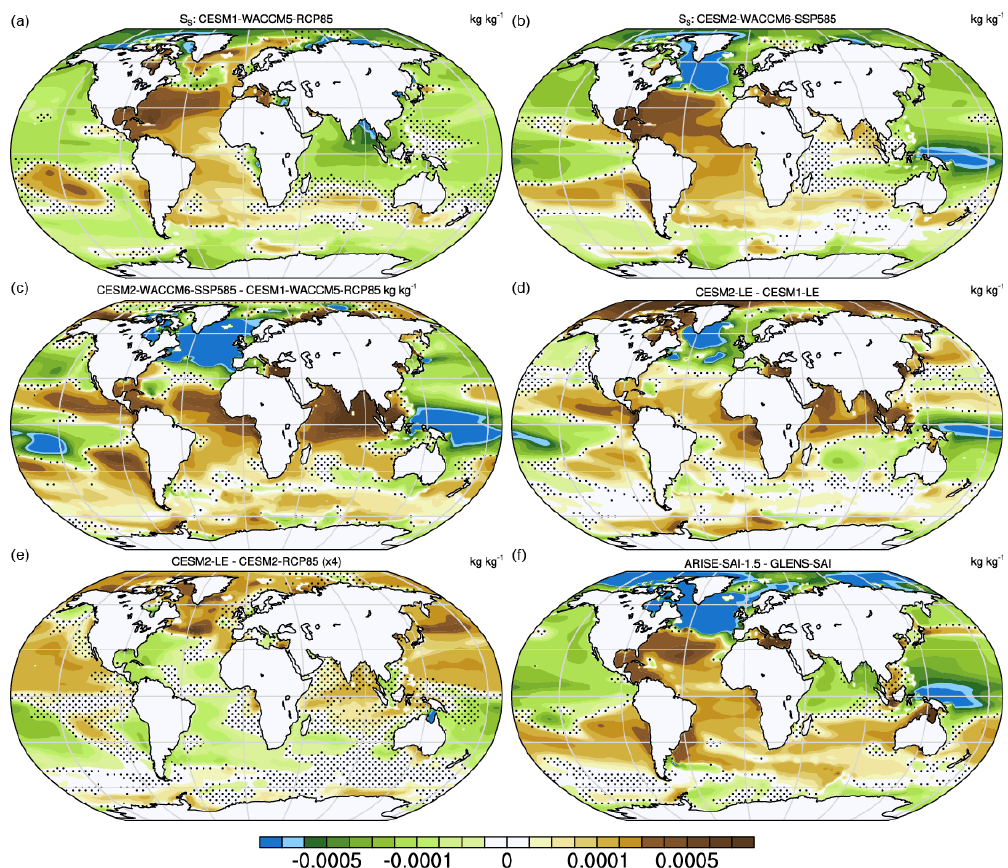
Figure A7. Response in surface salinity (S S ) estimated from the change between 2020–2039 and 2050–2069 for unmitigated (a) CESM1- WACCM5-RCP85 and (b) CESM2-WACCM6-SSP585 simulations, and their difference (c) . Also shown is the analogous difference for (d) CESM1-LE and CESM2-LE (d) and (e) CESM2-RCP85 and CESM2-LE. The difference between the geoengineered climate states in ARISE-SAI-1.5 and GLENS-SAI is shown in panel (f) . Units for all panels are kgkg − 1 , and stippled regions indicate differences that are less than twice the ensemble standard